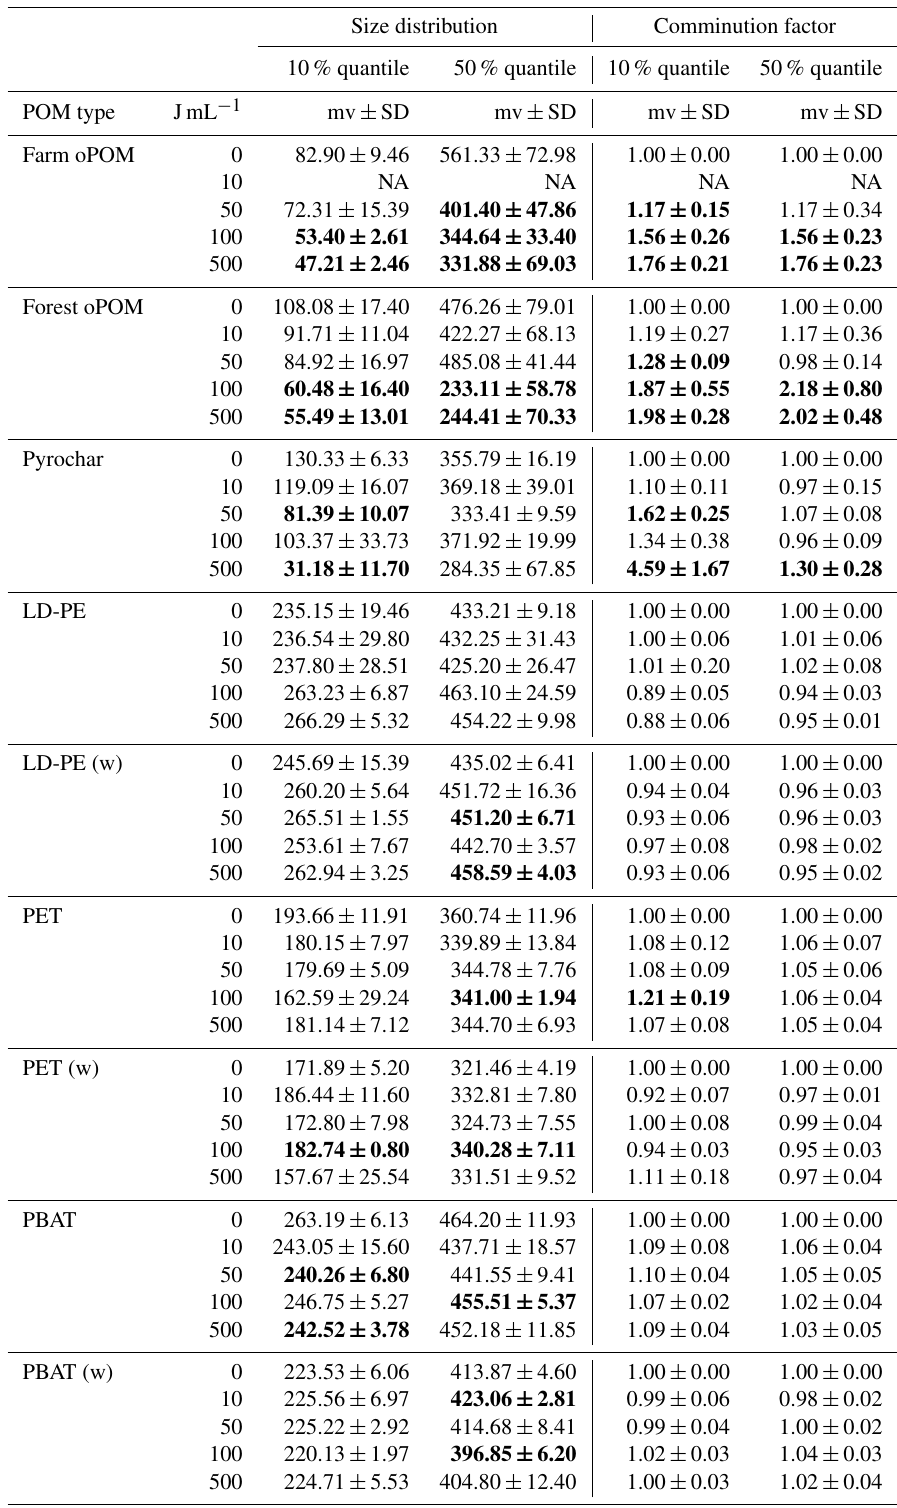
Table 2. Particle size distribution (10% and 50% quantile) and comminution factor of natural POM and microplastics after ultrasonic treatment with 0, 10, 50, 100 and 500JmL − 1 ( n = 3). The (w) marks weathered plastics, mv the mean value and SD the standard deviation. Bold numbers are significantly different from the 0JmL − 1 treatment by p < 0 . 05 and comminution factor > 1 .